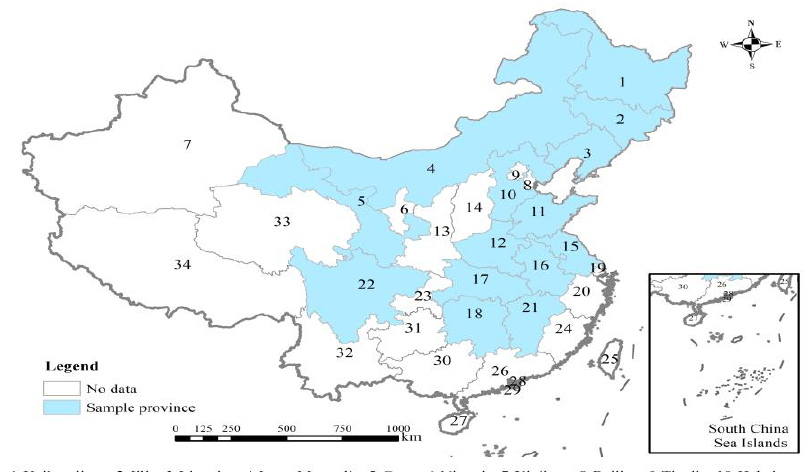
Figure 2. The spatial distribution of sample